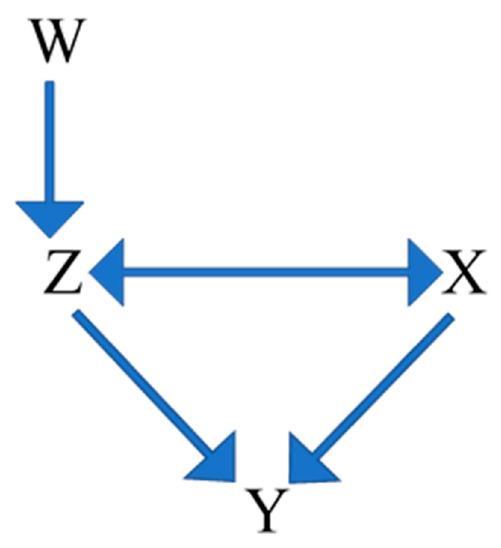
Figure 4 . Directed Graph . Figure 4. Directed Graph.